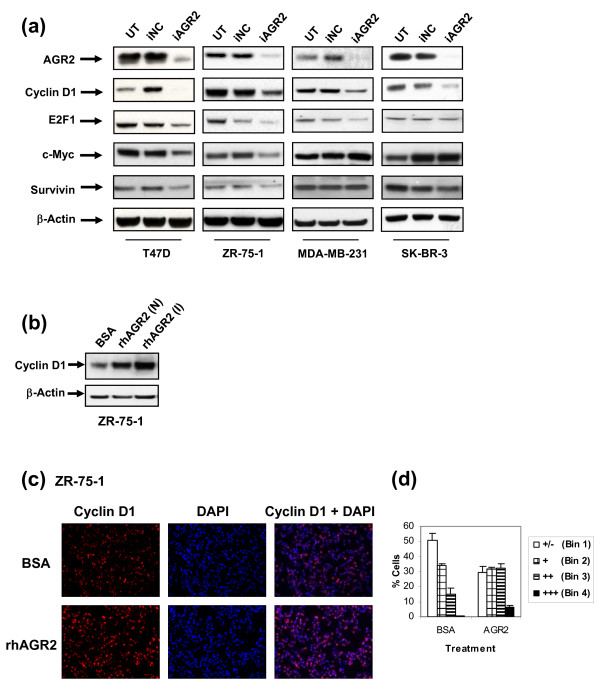
Target modulation of proliferation and survival proteins by AGR2. (a) Lysates 72 hours after transfection with nontargeting control (iNC) or AGR2 (iAGR2) were evaluated with Western blot for modulation of regulators of growth and survival. Note: Some blots may be from different gels run with the same set of samples. (b) ZR-75-1 cells were treated for 6 hours with BSA (5 μg/mL), Novus rhAGR2 (rhAGR2 (N)), or in-house rhAGR2 (rhAGR2(I)), and analyzed with Western blot for cyclin D1 induction. (c) ZR-75-1 cells were plated in eight-well chamber slides and treated with 5 μg/mL of BSA or rhAGR2 (I) for 6 hours. Cells were stained with cyclin D1, and mounting medium containing DAPI was used. Images were taken by using a fluorescent microscope and pseudo-colored in Adobe Photoshop. (d) Quantitation of cyclin D1 immunofluorescence images. The percentage of cells in each bin based on cyclin D1 intensity is represented (Bin 1, weakest staining; Bin 4, brightest staining). Results are expressed as the mean ± SD; n = 4.